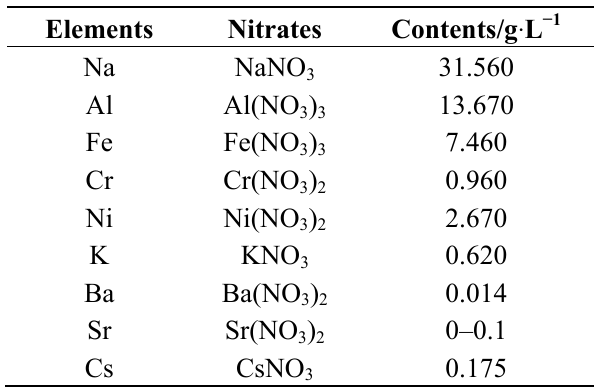
Table 1. The simulated low and intermediate level radioactive liquid waste